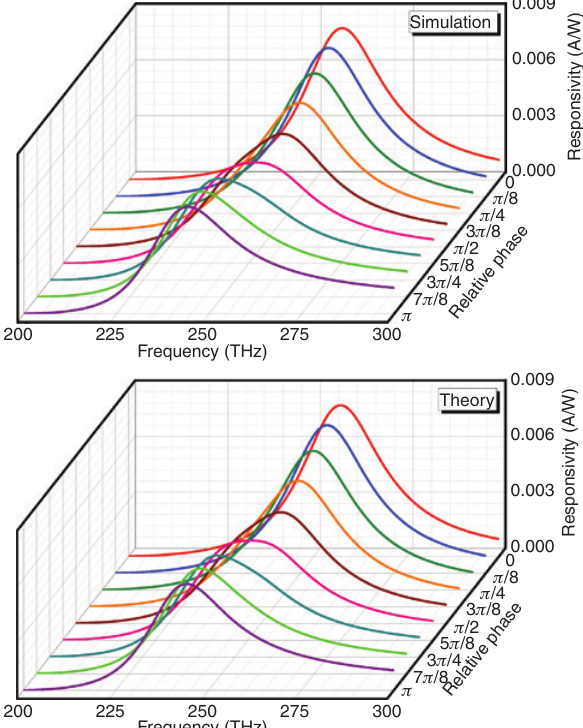
Figure 11: The spectrum of responsivity of hot-electron photodetection based on the PC-SCPA in our optical system possessing the phase coupling as a function of relative phase difference between two counterpropagating coherent light beams. Simulation and theoretical results are shown in the upper and lower panels,